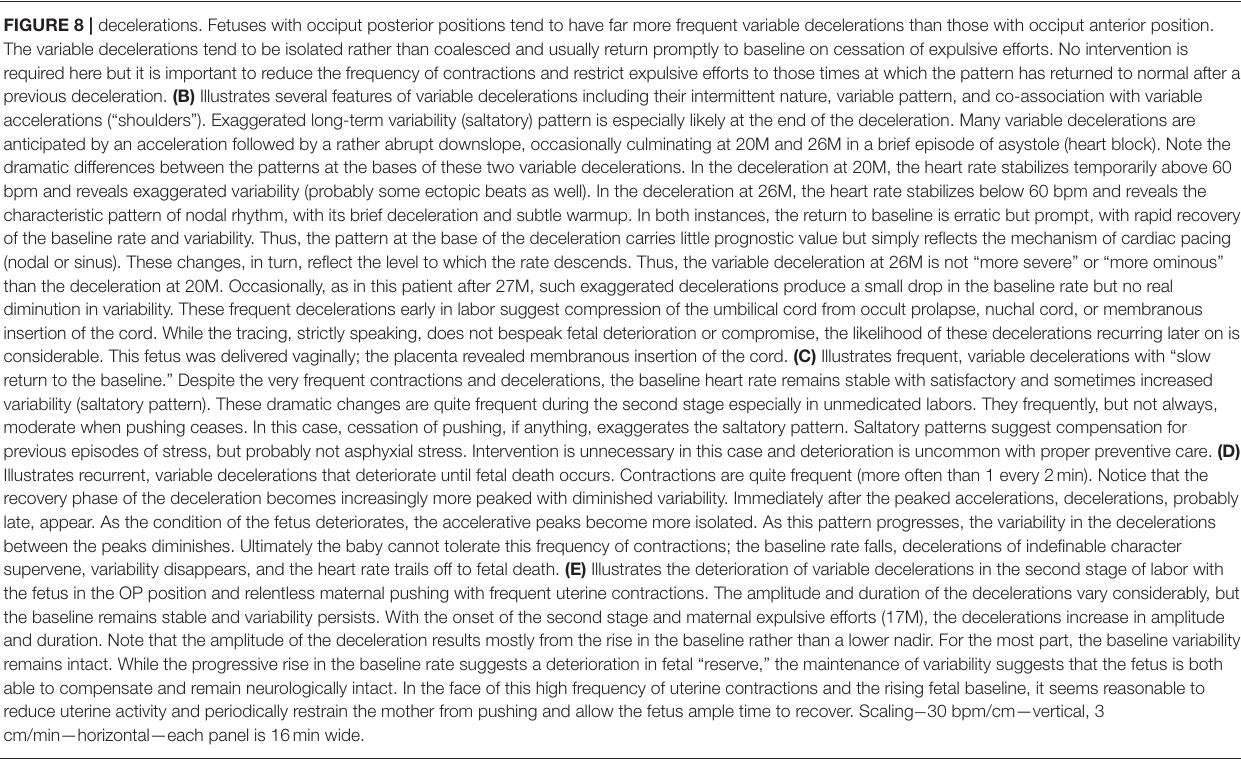
FIGURE 8 | decelerations. Fetuses with occiput posterior positions tend to have far more frequent variable decelerations than those with occiput anterior position. The variable decelerations tend to be isolated rather than coalesced and usually return promptly to baseline on cessation of expulsive efforts. No intervention is required here but it is important to reduce the frequency of contractions and restrict expulsive efforts to those times at which the pattern has returned to normal after a previous deceleration. (B) Illustrates several features of variable decelerations including their intermittent nature, variable pattern, and co-association with variable accelerations (“shoulders”). Exaggerated long-term variability (saltatory) pattern is especially likely at the end of the deceleration. Many variable decelerations are anticipated by an acceleration followed by a rather abrupt downslope, occasionally culminating at 20M and 26M in a brief episode of asystole (heart block). Note the dramatic differences between the patterns at the bases of these two variable decelerations. In the deceleration at 20M, the heart rate stabilizes temporarily above 60 bpm and reveals exaggerated variability (probably some ectopic beats as well). In the deceleration at 26M, the heart rate stabilizes below 60 bpm and reveals the characteristic pattern of nodal rhythm, with its brief deceleration and subtle warmup. In both instances, the return to baseline is erratic but prompt, with rapid recovery of the baseline rate and variability. Thus, the pattern at the base of the deceleration carries little prognostic value but simply reflects the mechanism of cardiac pacing (nodal or sinus). These changes, in turn, reflect the level to which the rate descends. Thus, the variable deceleration at 26M is not “more severe” or “more ominous” than the deceleration at 20M. Occasionally, as in this patient after 27M, such exaggerated decelerations produce a small drop in the baseline rate but no real diminution in variability. These frequent decelerations early in labor suggest compression of the umbilical cord from occult prolapse, nuchal cord, or membranous insertion of the cord. While the tracing, strictly speaking, does not bespeak fetal deterioration or compromise, the likelihood of these decelerations recurring later on is considerable. This fetus was delivered vaginally; the placenta revealed membranous insertion of the cord. (C) Illustrates frequent, variable decelerations with “slow return to the baseline.” Despite the very frequent contractions and decelerations, the baseline heart rate remains stable with satisfactory and sometimes increased variability (saltatory pattern). These dramatic changes are quite frequent during the second stage especially in unmedicated labors. They frequently, but not always, moderate when pushing ceases. In this case, cessation of pushing, if anything, exaggerates the saltatory pattern. Saltatory patterns suggest compensation for previous episodes of stress, but probably not asphyxial stress. Intervention is unnecessary in this case and deterioration is uncommon with proper preventive care. (D) Illustrates recurrent, variable decelerations that deteriorate until fetal death occurs. Contractions are quite frequent (more often than 1 every 2min). Notice that the recovery phase of the deceleration becomes increasingly more peaked with diminished variability. Immediately after the peaked accelerations, decelerations, probably late, appear. As the condition of the fetus deteriorates, the accelerative peaks become more isolated. As this pattern progresses, the variability in the decelerations between the peaks diminishes. Ultimately the baby cannot tolerate this frequency of contractions; the baseline rate falls, decelerations of indefinable character supervene, variability disappears, and the heart rate trails off to fetal death. (E) Illustrates the deterioration of variable decelerations in the second stage of labor with the fetus in the OP position and relentless maternal pushing with frequent uterine contractions. The amplitude and duration of the decelerations vary considerably, but the baseline remains stable and variability persists. With the onset of the second stage and maternal expulsive efforts (17M), the decelerations increase in amplitude and duration. Note that the amplitude of the deceleration results mostly from the rise in the baseline rather than a lower nadir. For the most part, the baseline variability remains intact. While the progressive rise in the baseline rate suggests a deterioration in fetal “reserve,” the maintenance of variability suggests that the fetus is both able to compensate and remain neurologically intact. In the face of this high frequency of uterine contractions and the rising fetal baseline, it seems reasonable to reduce uterine activity and periodically restrain the mother from pushing and allow the fetus ample time to recover. Scaling − 30 bpm/cm—vertical, 3 cm/min—horizontal—each panel is 16min